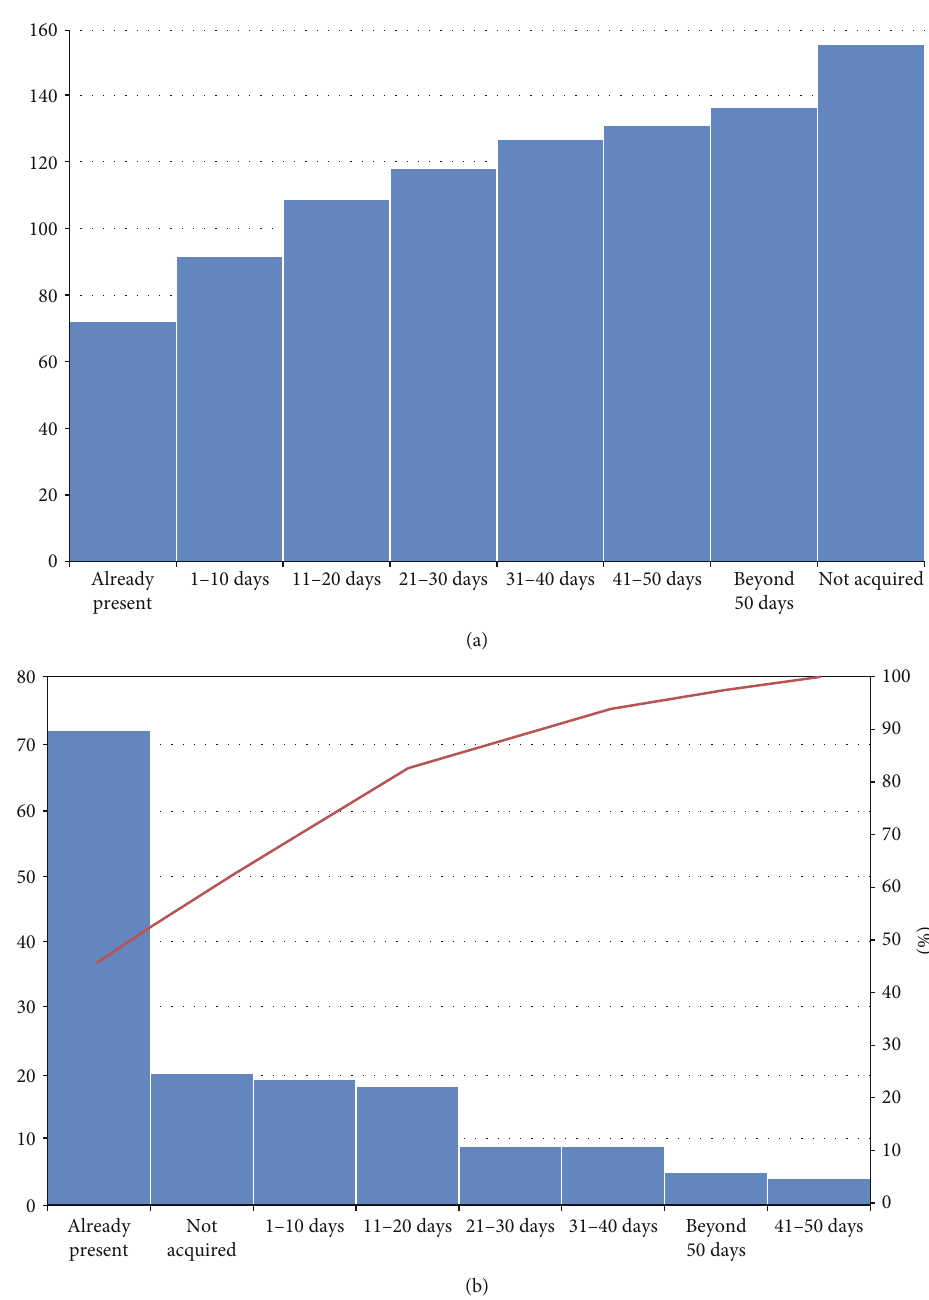
Figure 4: (a) Cumulative frequencies of functional arm acquisition times; abscissa, times of milestone acquisition; ordinate, absolute number of patients. (b) Single frequencies of milestone acquisition, ordered according to their frequency; columns, absolute number of patients; line, cumulative